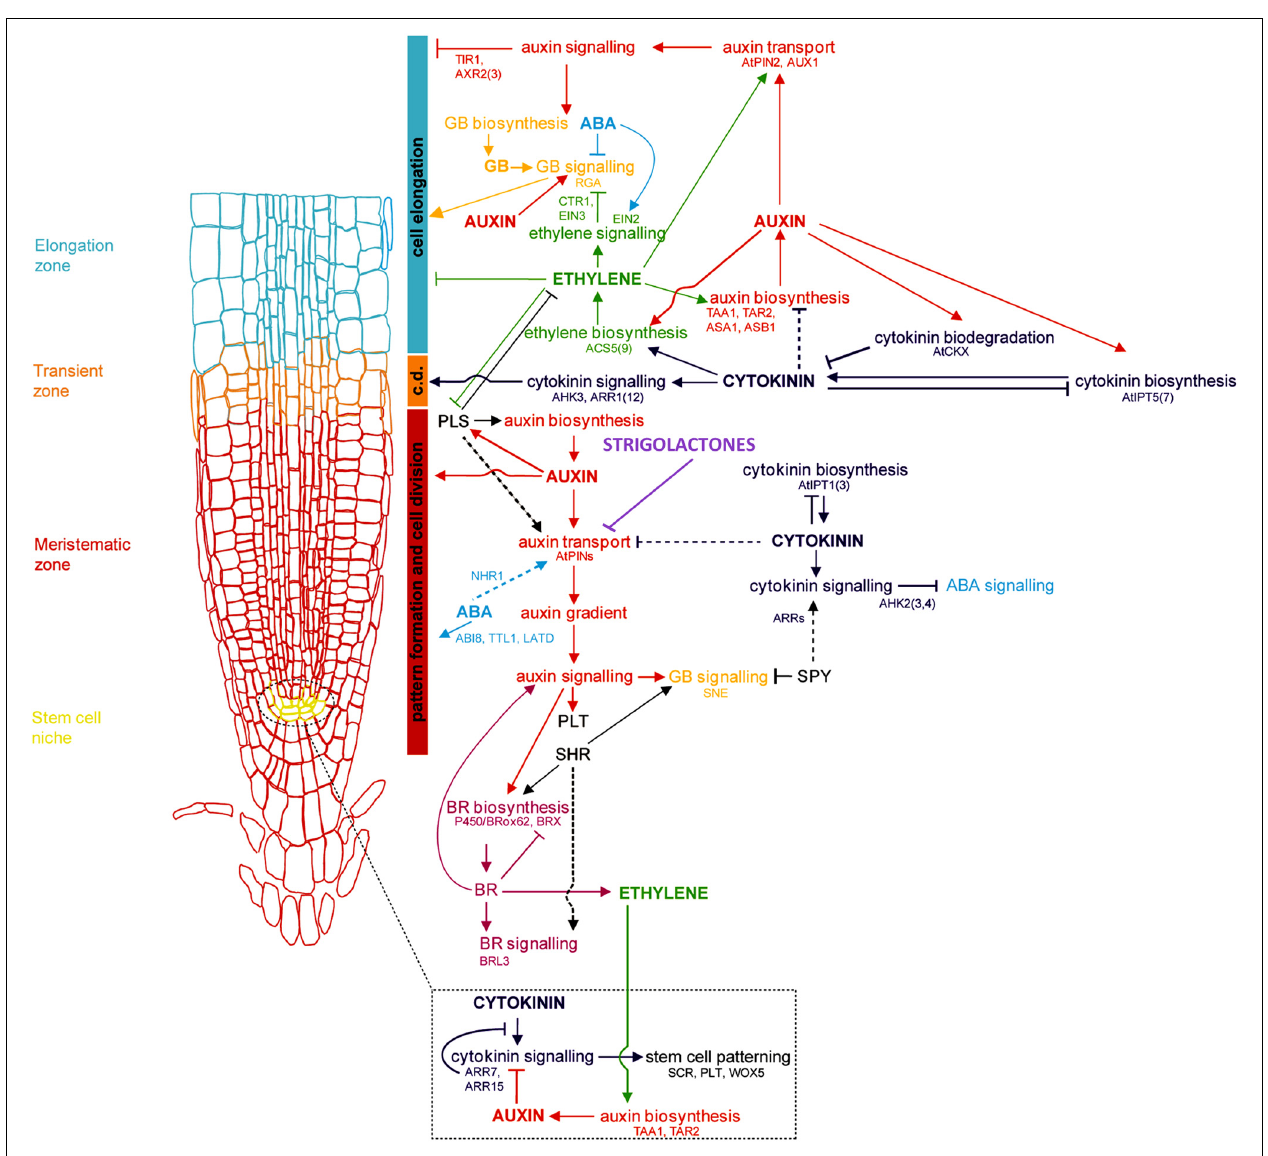
FIGURE 1 | Genetic and hormonal control of primary root development in Arabidopsis Model of the current understanding of hormone interaction and genetic regulation of primary root and general root apical meristem growth and development in Arabidopsis . Important genes involved in integrating signals from different hormone pathways are shown in black; hormone networks are color-coded; dashed lines represent unresolved or indirect relations.The fundamental role of auxin-mediated